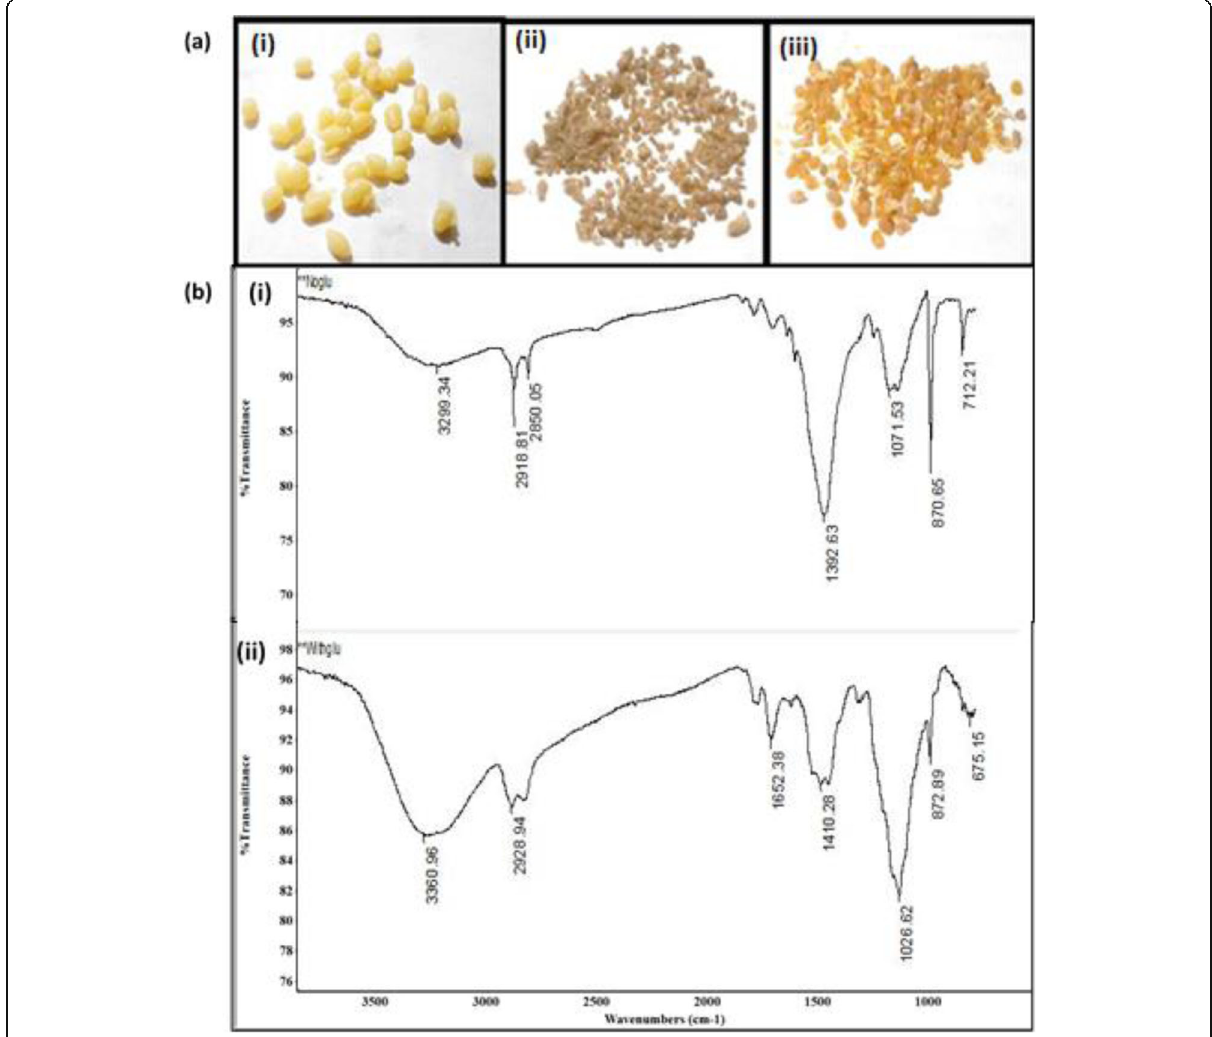
Fig. 6 Characterization of chitosan beads. a Chitosan beads forms : i chitosan before drying, ii chitosan after drying, and iii chitosan with glutaraldehyde after drying. b FT-IR spectra of dried chitosan (i) and chitosan with glutaraldehyde (ii)